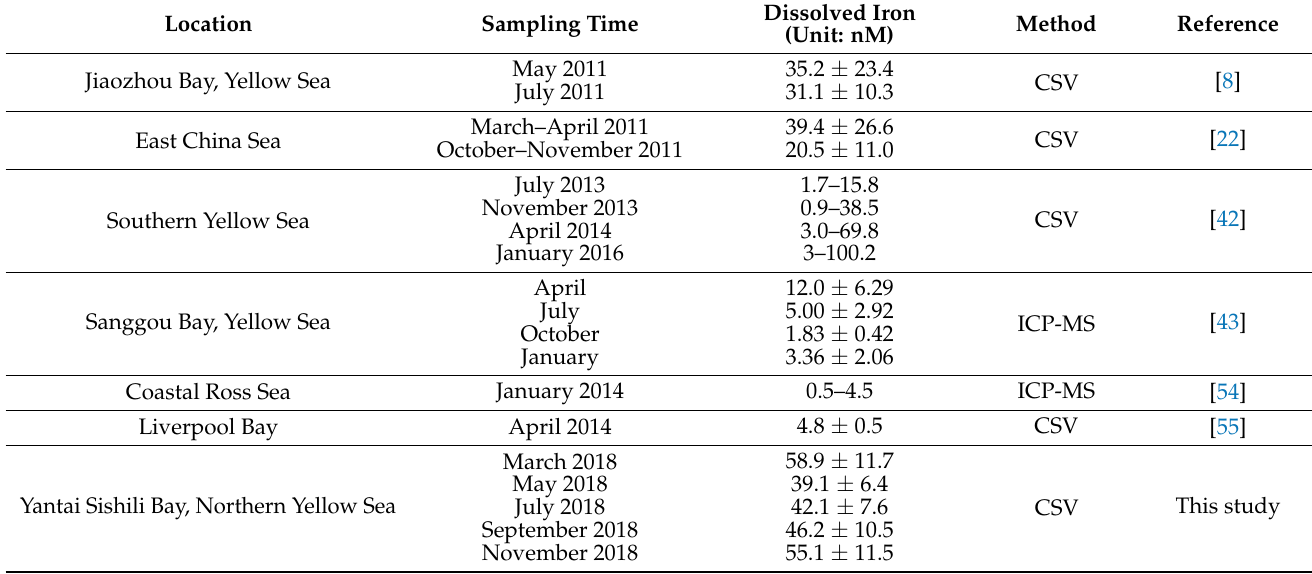
Table 3. Comparison of dissolved iron in Sishili Bay with other